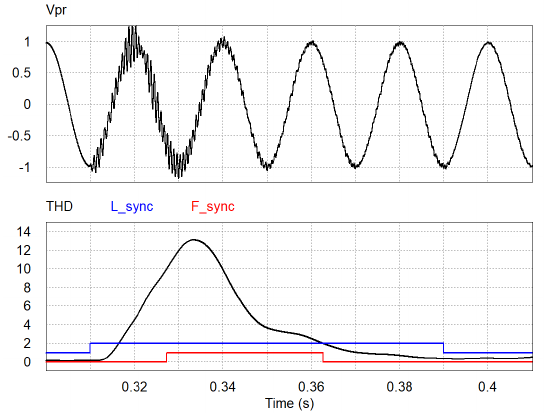
Figure 20. Primary voltage resonance detection and avoidance in single-side feeding (resonance starts t =0.31 s and is detected at around t =0.33 s). Traces: Vpr - primary voltage, THD - total harmonic distortion, L_sync - loss of synchronism, F_sync - fault of synchronism.